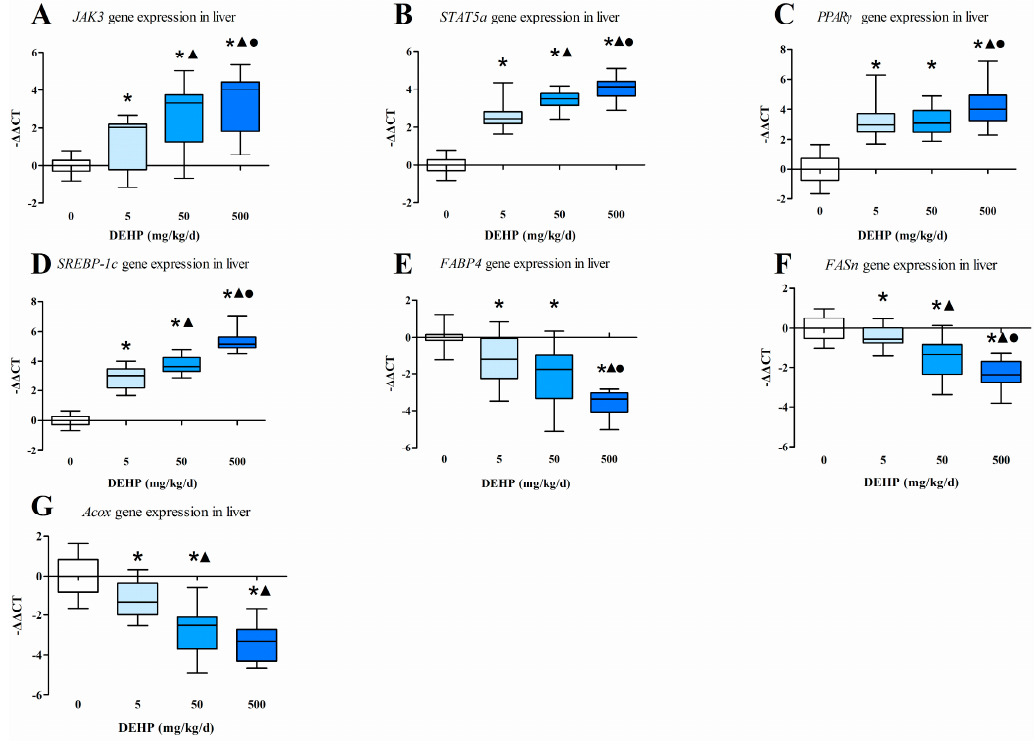
Figure 2. Effects of DEHP on expression of the JAK3/STAT5 pathway genes in liver ( n = 20 animals/each group): ( A ) The fold change of mRNA levels of JAK3 in liver; ( B ) The fold change of mRNA levels of STAT5a in liver; ( C ) The fold change of mRNA levels of PPAR γ in liver; ( D ) The fold change of mRNA levels of SREBP-1c in liver; ( E ) The fold change of mRNA levels of FABP4 in liver; ( F ) The fold change of mRNA levels of FASn in liver; ( G ) The fold change of mRNA levels of Acox in liver. All data was expressed as the min to max and the median. • Statistically significant difference compared with 50 mg·kg − 1 ·d − 1 ( p < 0.05); ▲ Statistically significant difference compared with 5 mg·kg − 1 ·d − 1 ( p < 0.05); * Statistically significant difference compared with control ( p < 0.05).